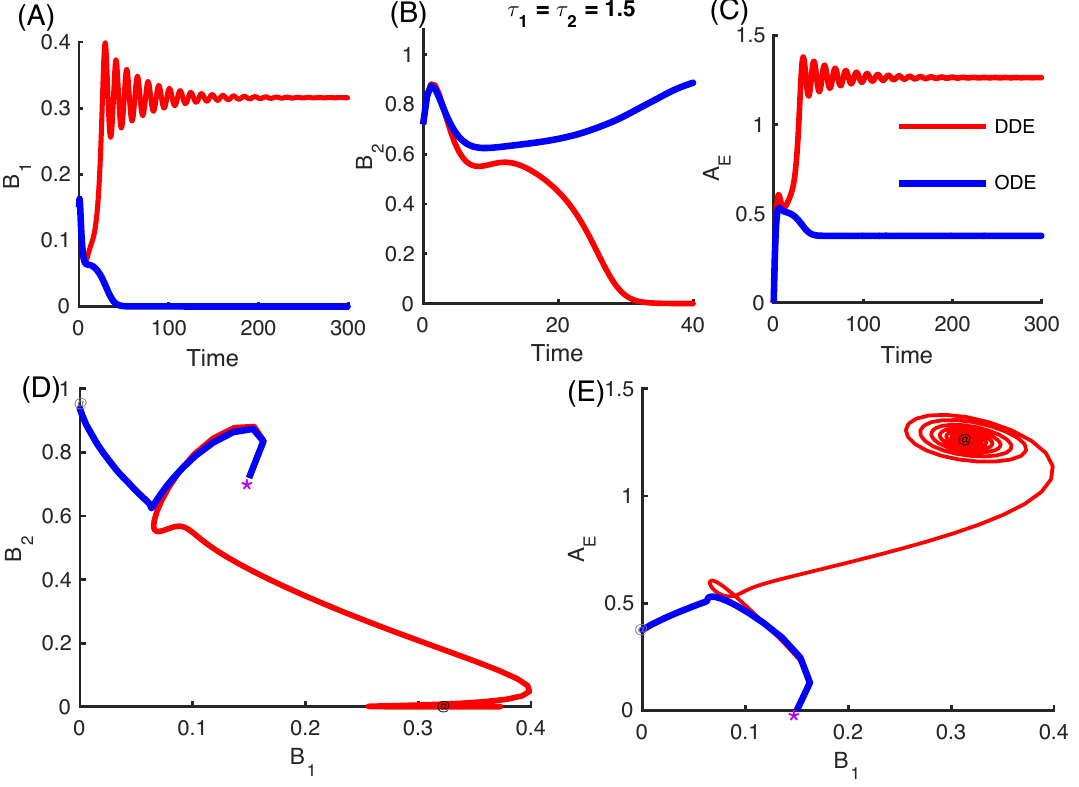
Figure 9. Effect of small time delays ( τ 1 = τ 2 = 1.5) in the competition M2 model (41)–(43). ( A – C ) Time courses of the populations of bad bacteria ( B 1 in (A)) and good bacteria ( B 2 in (B)) and immune response ( A E in (C)) in the absence (blue solid lines) and presence (red dashed lines) of time delays; ( D ) the corresponding trajectories of B 1 and B 2 in (A,B) in the phase plane; ( E ) the corresponding trajectories of B 1 and A E in (B,C) in the phase plane. The introduction of weak time delays in the system induces a switch from the B2-dominant equilibrium (0, B s ,2 Initial condition: B 1 ( 0 ) = 0.15, B 2 ( 0 ) = 0.72, A E ( 0 ) = 0.0. All other parameters are fixed as in Table 4 (Type